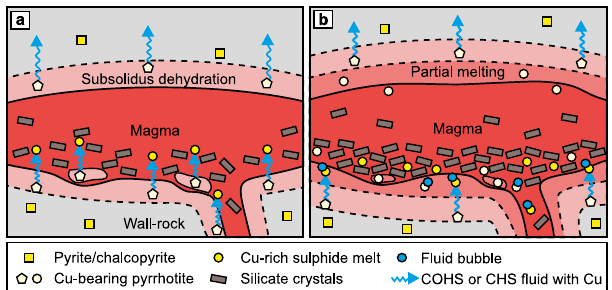
Fig. 6 Schematic illustration of sulphide mobilization in a developing black shale contact aureole and the modes of assimilation by the magma. a Devolatilization reactions in the wall-rock footwall and xenoliths form a COHS- or CHS- fl uid. The fl uid transports sulphur and copper from the footwall and xenoliths to the magma causing sulphide saturation. b As the heating of the wall-rock progresses, partial melting zones form close to the intrusion. At this stage, sulphides are suspended in silicate melt and can be assimilated by the magma. In the outer devolatilization zone (similar to that in a) in the footwall, fl uids migrate to the partial melting zone forming sulphide- fl uid composite droplets. The low-density fl uid enhances buoyant ascent of the sulphide droplets suspended in silicate melt in the feeder dike and in the